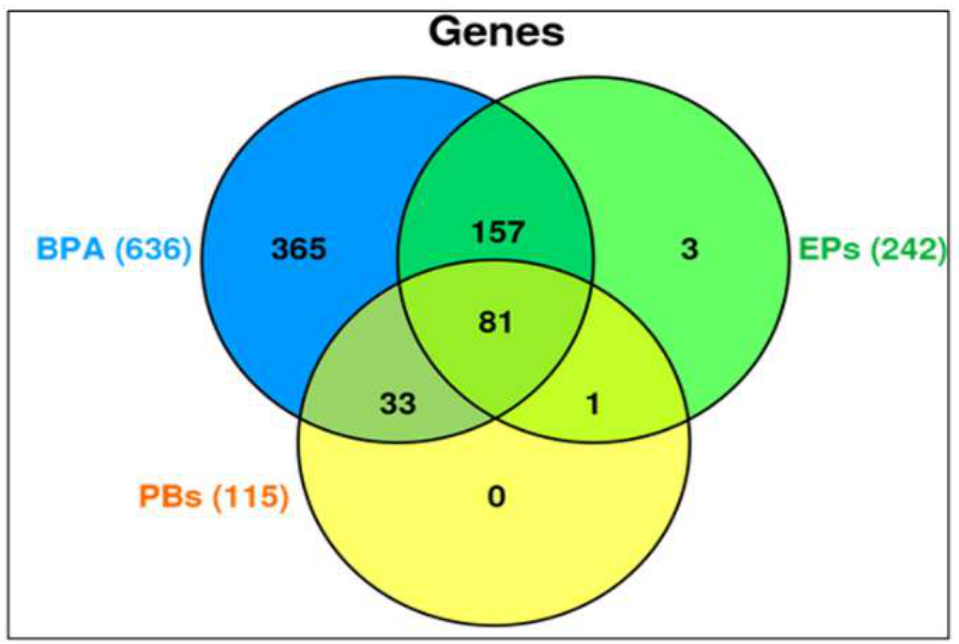
Figure 3. Venn diagram generated from CTD analyses of genes that are influenced by the exposure of BPA, EPs, and PBs separately or in combinations associated with the PCa outcomes. BPA was separated from EP chemical groups because, separately, BPA influenced the highest number (636 genes).